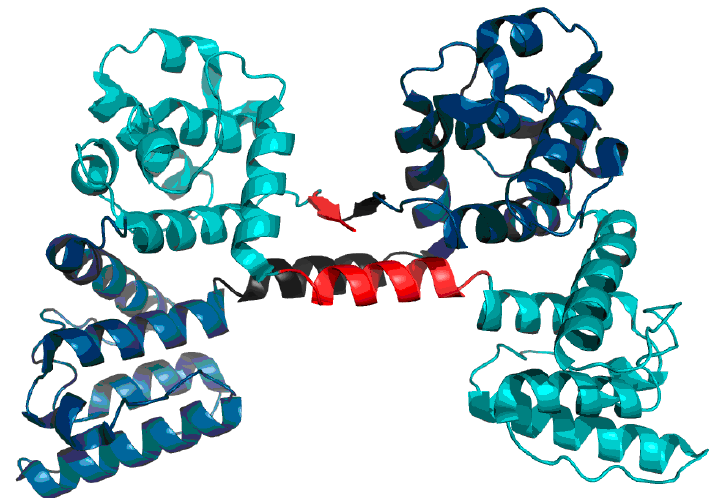
Figure 8. Structure of dystrophin: chain A ( turquoise ) with two fragments of the B chain ( dark blue ). The red fragments of the A chain interact with the corresponding black fragments of the B chain to produce the FOD domain.